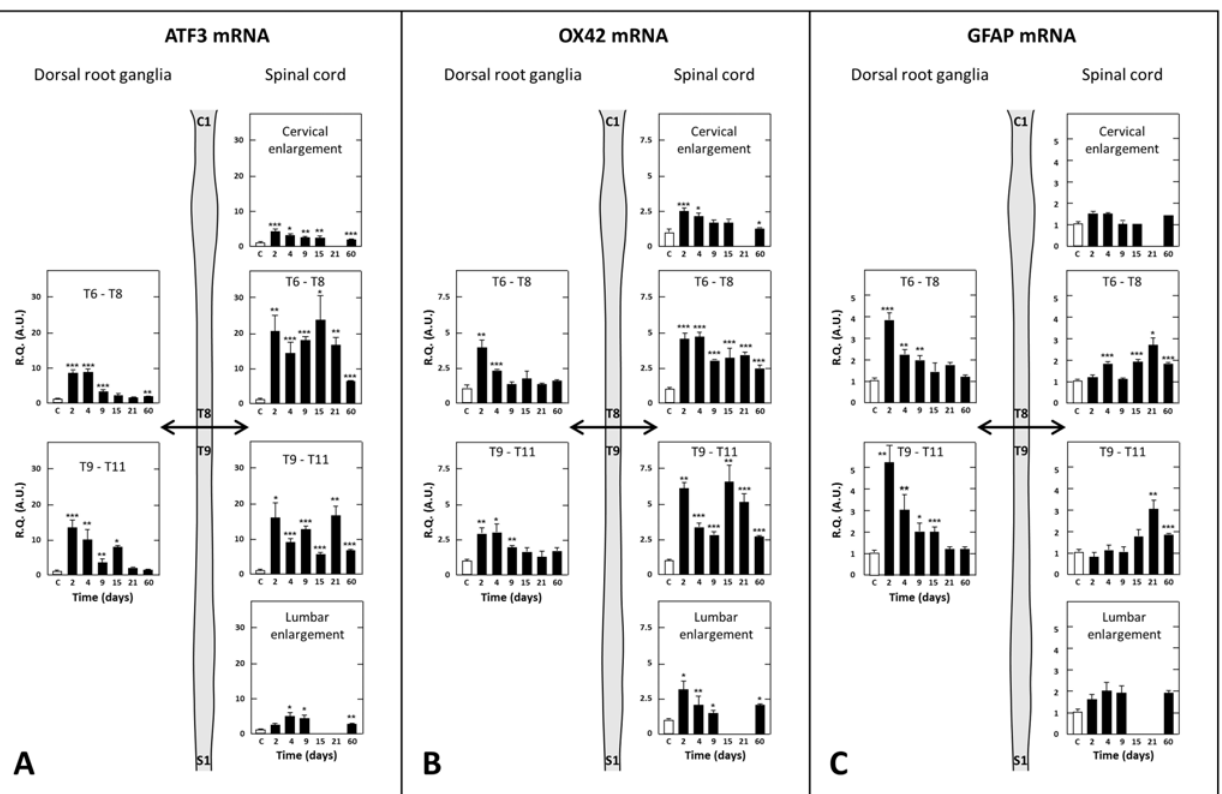
Fig 7. Time-course changes in tissue levels of transcripts encoding ATF3 (A), OX-42 (B) or GFAP (C) in dorsal root ganglia and spinal cord at various times after spinal cord transection. Real-time RT-qPCR determinations were made in T6 – T8 and T9 – T11 dorsal root ganglia, T6 – T8 and T9 – T11 spinal cord segments and the cervical and lumbar enlargements at various times (in days, D, abscissa) after spinal cord transection at T8 – T9 level. Data are expressed as the ratio of specific mRNA over GaPDH mRNA [R.Q.(A.U.)]. Each bar is the mean + S.E.M. of n independent determinations (D2, D4, D9, D15, D21: n = 6; D60: n = 12). Sham values at every postoperative time are pooled under “ C ” (control) on abscissa. * P < 0.05, ** P < 0.01, *** P < 0.001 compared to respective values in sham-operated rats (C).Two-way ANOVA followed by Bonferroni test.